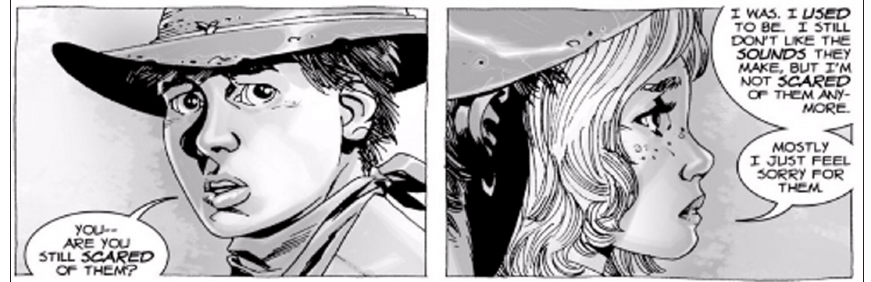
Figure 3: Kirkman, Robert (w) and Charlie Adlard (a). Two panels from a page Kirkman, R. 2007. The Walking Dead : Book 2. © 2007 Image